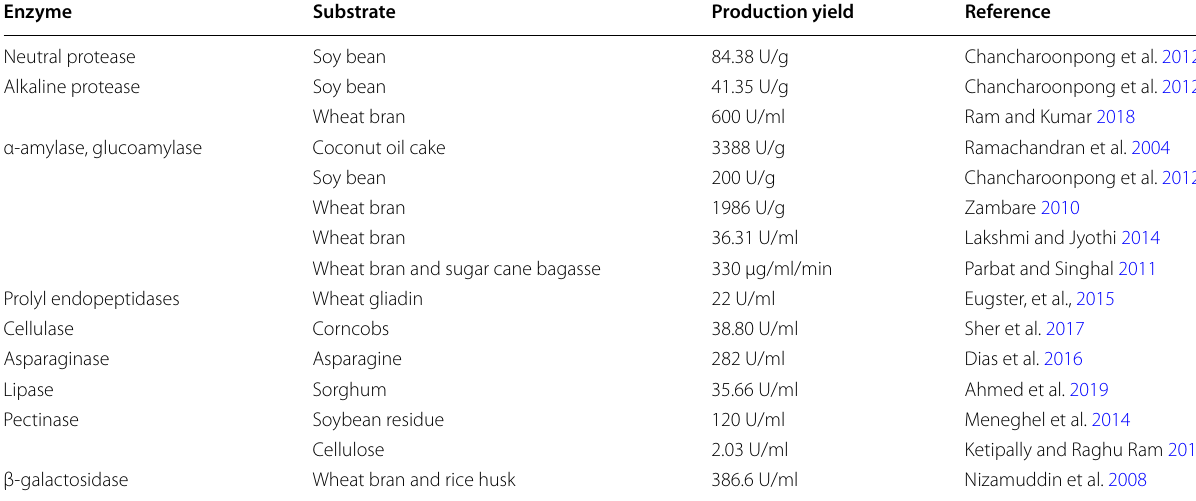
Table 3 Some industrial enzymes originated from A. oryzae and their substrates